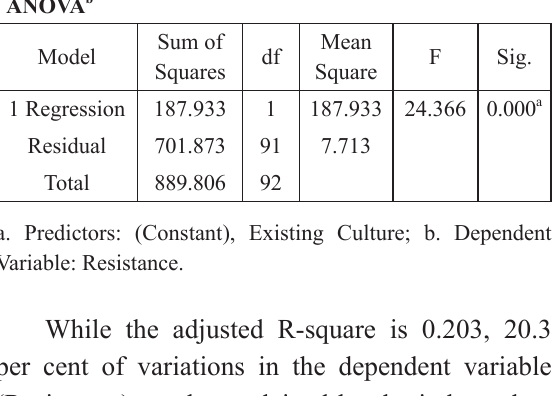
One Way ANOVA for Existing Culture and Resistance.